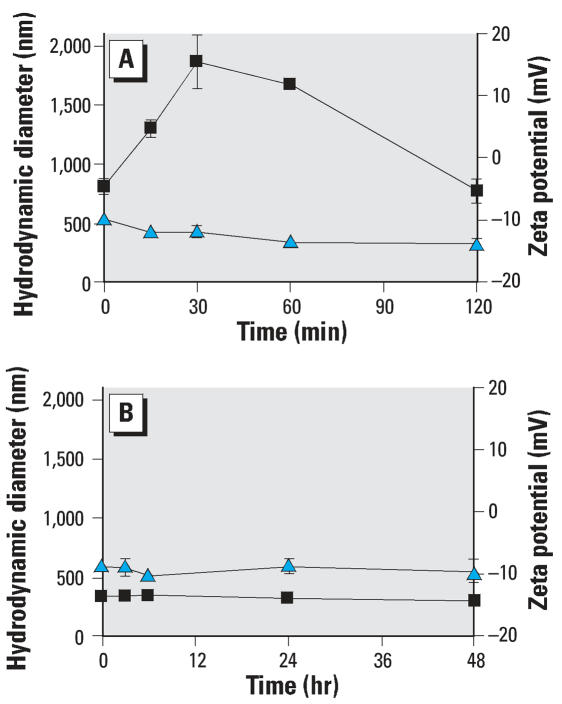
The aggregate size and zeta potential of P25 (20 ppm) were measured in both HBSS and RPMI at conditions that paralleled the biological responses. (A) P25 aggregates reached 1,900 nm in size over a 30-min measurement in HBSS (25°C) and maintained > 1,000 nm size for the 2-hr exposure period. The zeta potential of P25 (blue triangles) initially measured –9.8 mV and decreased slightly over the 2-hr period. (B) Both the aggregate size (black squares; 300–350 nm) and zeta potential (blue triangles) (–8 mV to –10 mV) of P25 remained stable when measured in RPMI over the 48-hr period.